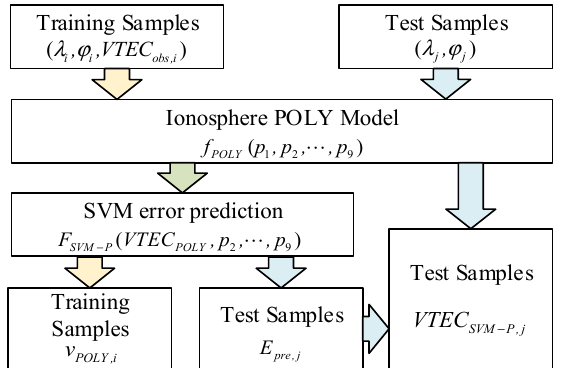
Figure 2. The flow chart of the Support Vector Machine polynomial (SVM-P) modeling process.